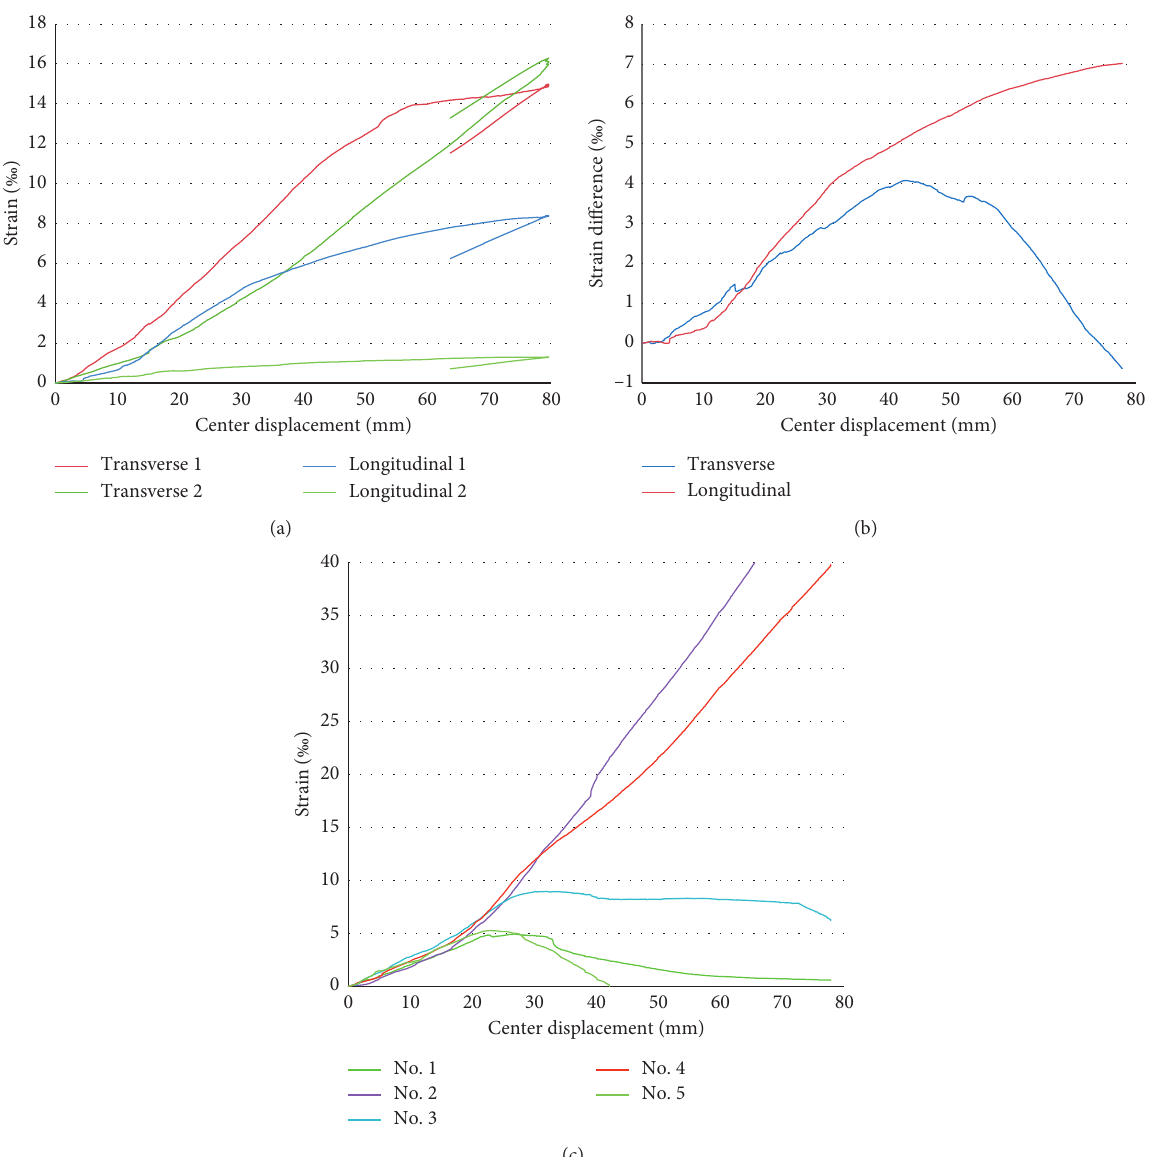
Figure 9: Strain-displacement curves. (a) Load point strain. (b) Transverse and longitudinal strain differences. (c) Costal board